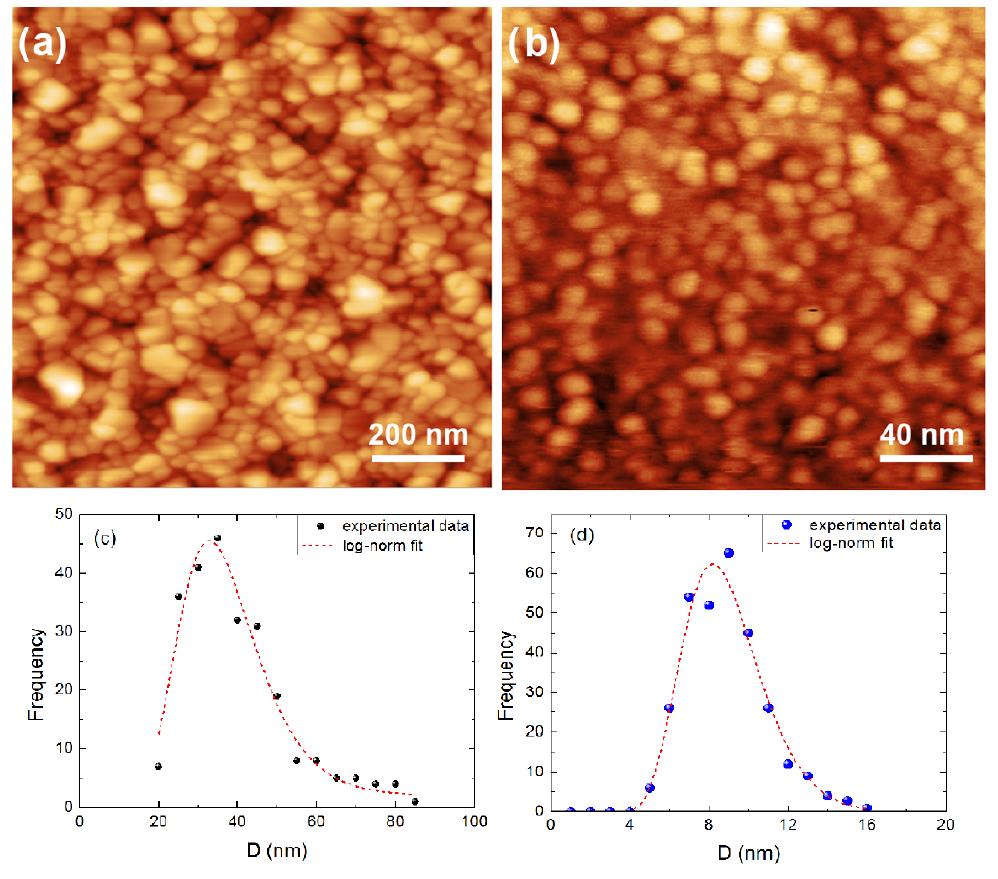
Figure 2. Atomic Force images of ( a ) 400 nm and ( b ) 4.7 nm thick rutile films. In ( c , d ) the corresponding experimental-data distributions of the grain size and the log-normal fittings are